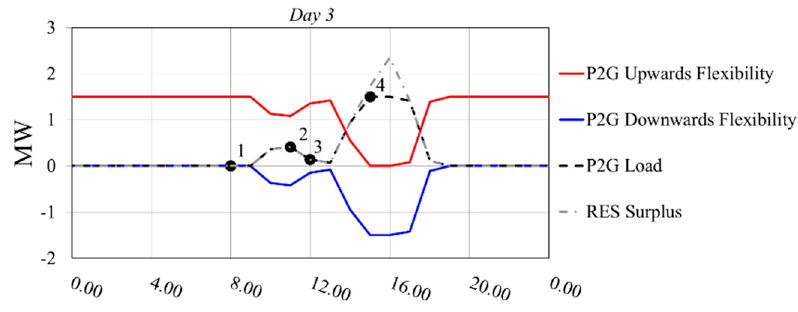
Figure 9. P2G flexibility evolution. Details of Day 3.